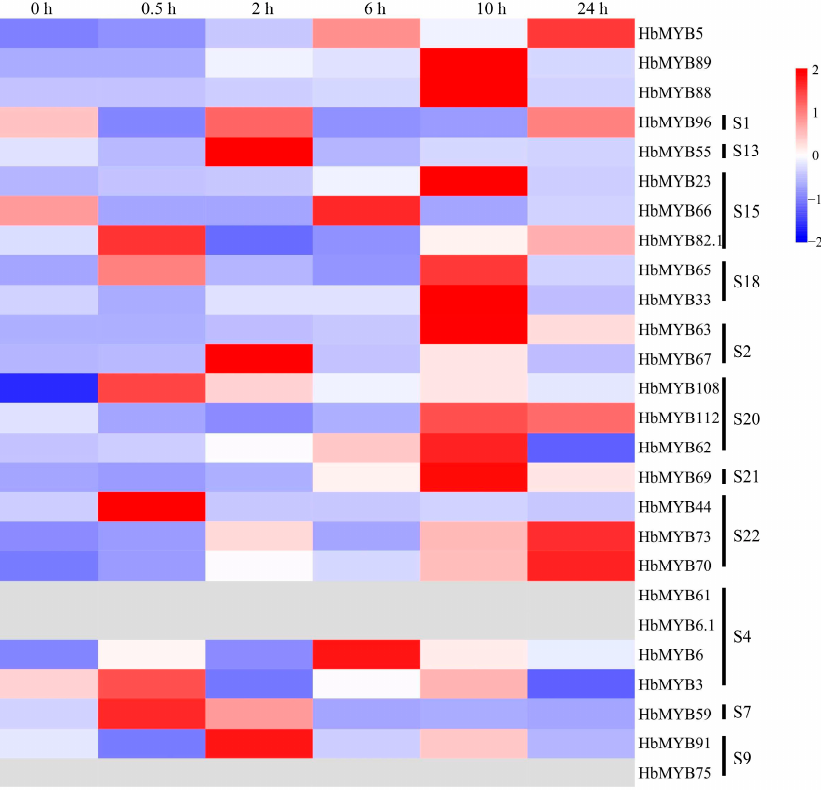
Figure 7. Expression analysis of HbR2R3-MYBs in rubber trees under ETH treatment.